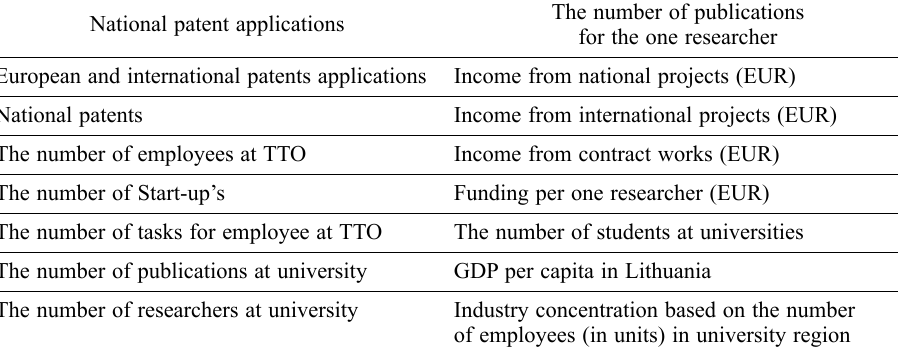
Table 3. Criteria that influences TTO performance